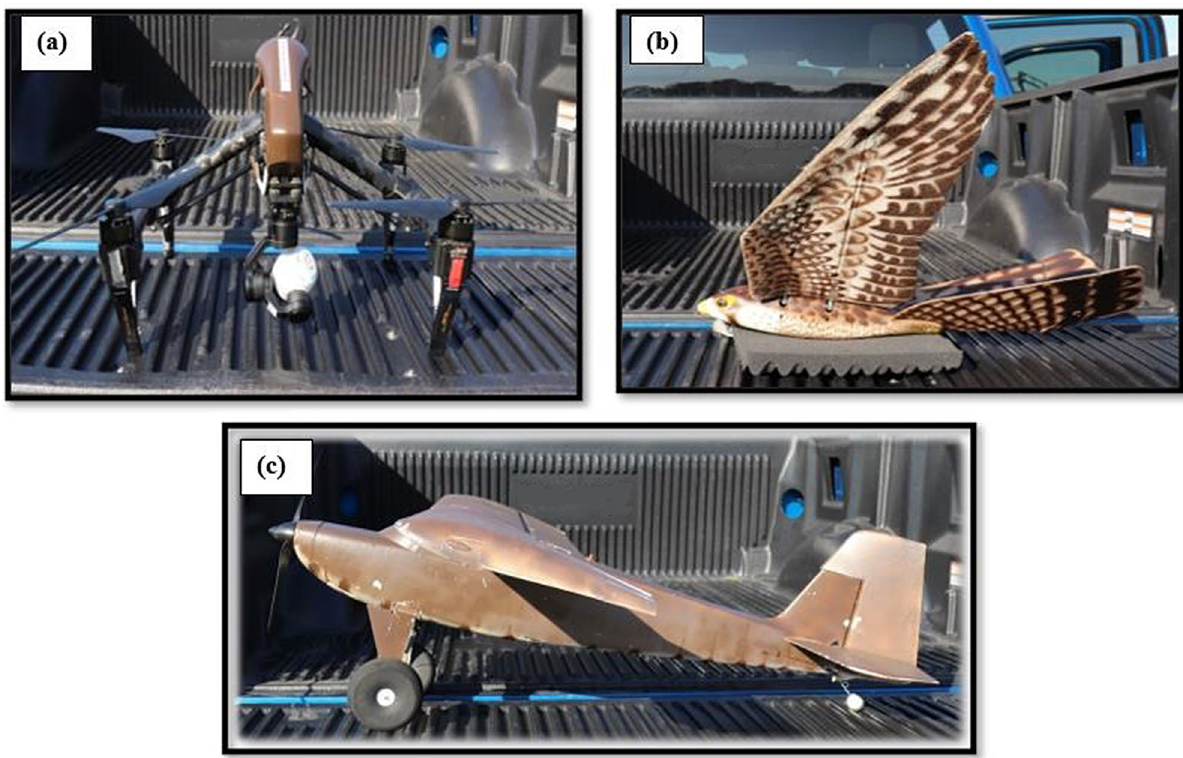
Figure 2. Photographs of the ( a ) multirotor ( DJI Inspire 1 V1.0 Da-Jiang Innovations Shenzhen, China), ( b ) ornithopter (Robird version 3, Clear Flight Solutions, Institutenweg, Netherlands), and ( c ) fixed-wing